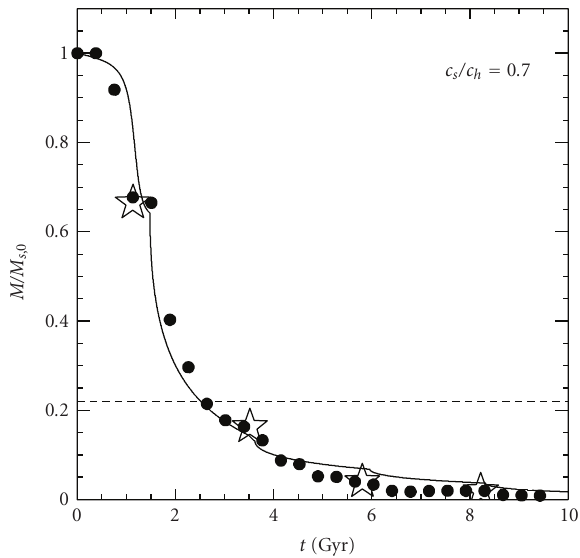
Figure 1: Bound mass in units of the initial mass as a function of time, for a (dark-matter-only) satellite moving on an eccentric orbit within a Milky Way halo potential (see [27] for details). The mass of the satellite is 1 / 50 of the mass of the primary and both are modeled with NFW halos. The ratio between the concentration parameter of the halo and satellite is c s /c h = 0 . 7, where c h = 10 is the concentration of the primary halo. The symbols are the N-Body data and the solid line shows the results of the semianalytical model described in Ta ff oni et al. [27], that includes both tidal truncation and tidal shocks (see text). Stars identify each pericentre passage. The dashed line is the bound mass that would remain if only tidal truncation is